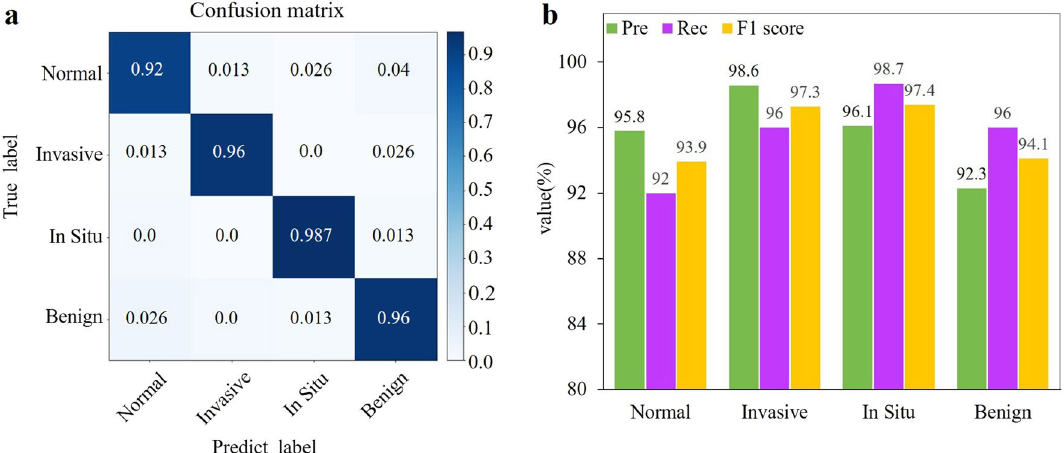
Figure 8. Results of the whole network on the Yan’s dataset. ( a ) Confusion matrix illustrating the classification done by MSMV-PFENet. ( b ) Histogram of the precision, recall and F1 score for the evaluation of MSMV-